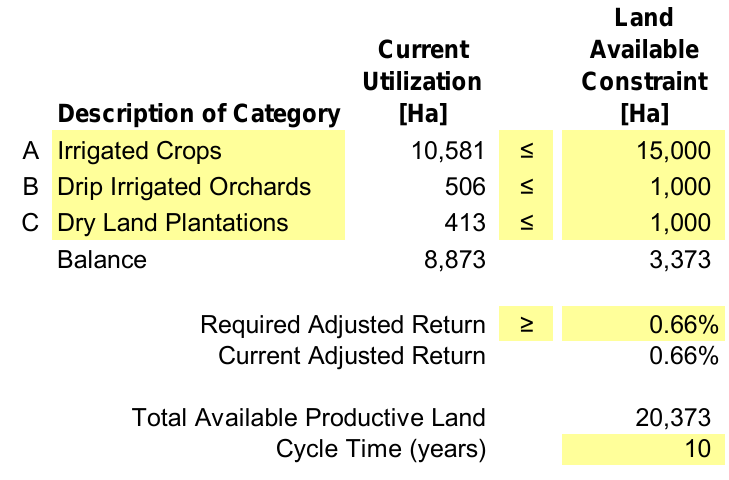
Figure 3 - Category and land available